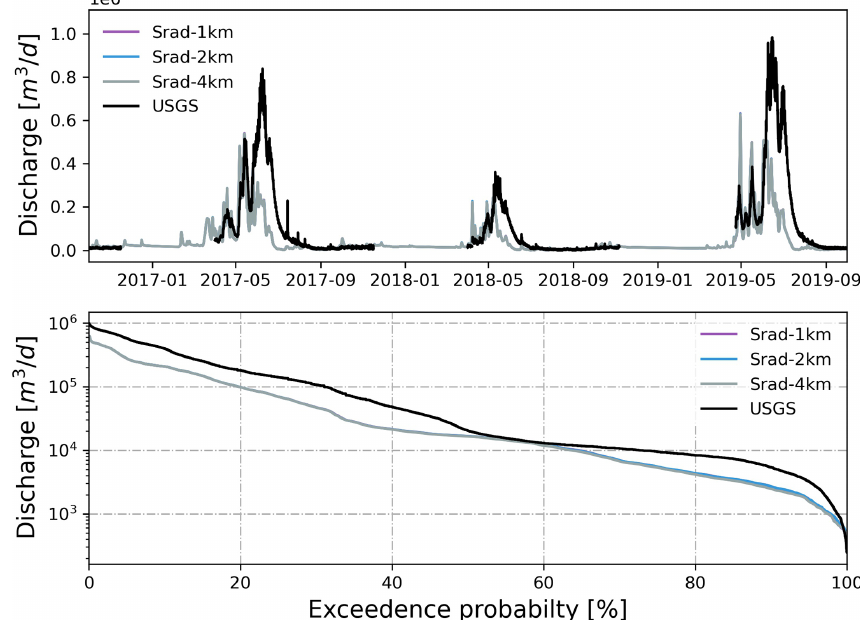
Figure A5. Simulated watershed outlet discharge under different spatial resolutions of S rad . Also shown is the flow duration curve compari-